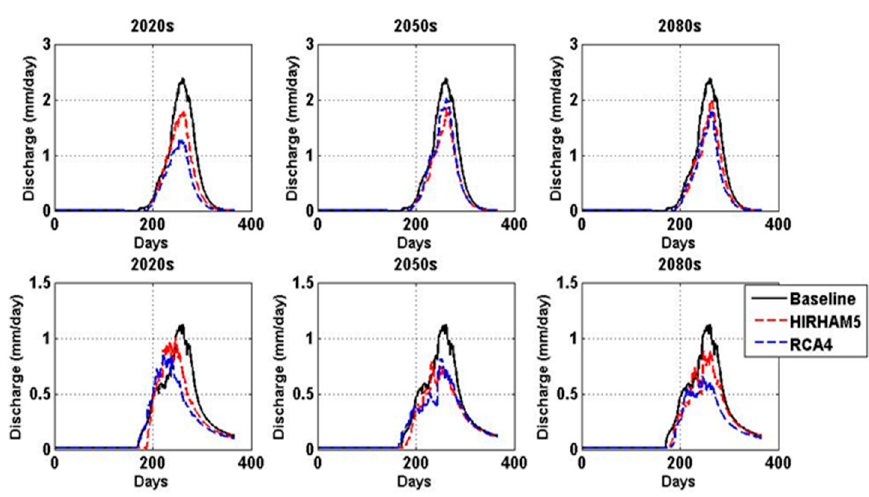
Figure 10. Average hydrographs for HIRHAM5 and RCA4 projections for the 2020s, 2050s and 2080s time horizons and the 1961–1990 baseline for the Bétérou catchment ( top ) and Bonou catchment ( bottom ) derived from RCP8.5 scenarios.